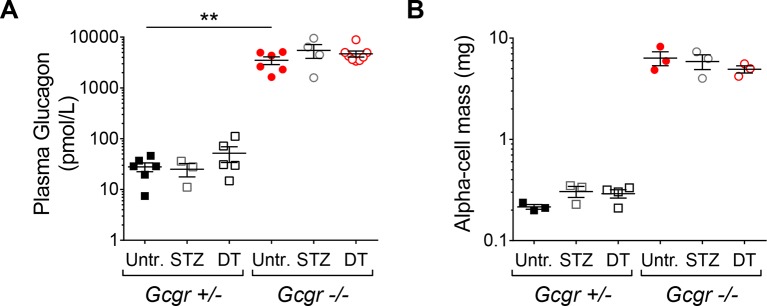
RIP-DTR;Gcgr-/- mice remain hyperglucagonemic and α-cell mass is not affected after STZ- or DT-treatment.(A-B) fed plasma glucagon levels (A) and α-cell mass (B) in untreated (Untr.), STZ-, or DT-treated RIP-DTR;Gcgr+/- and RIP-DTR;Gcgr-/- males and females, measured 6 days after the last injection. STZ administration: two injections (200 and 150 mg/kg). **p<0.01; Mann-Whitney U test.